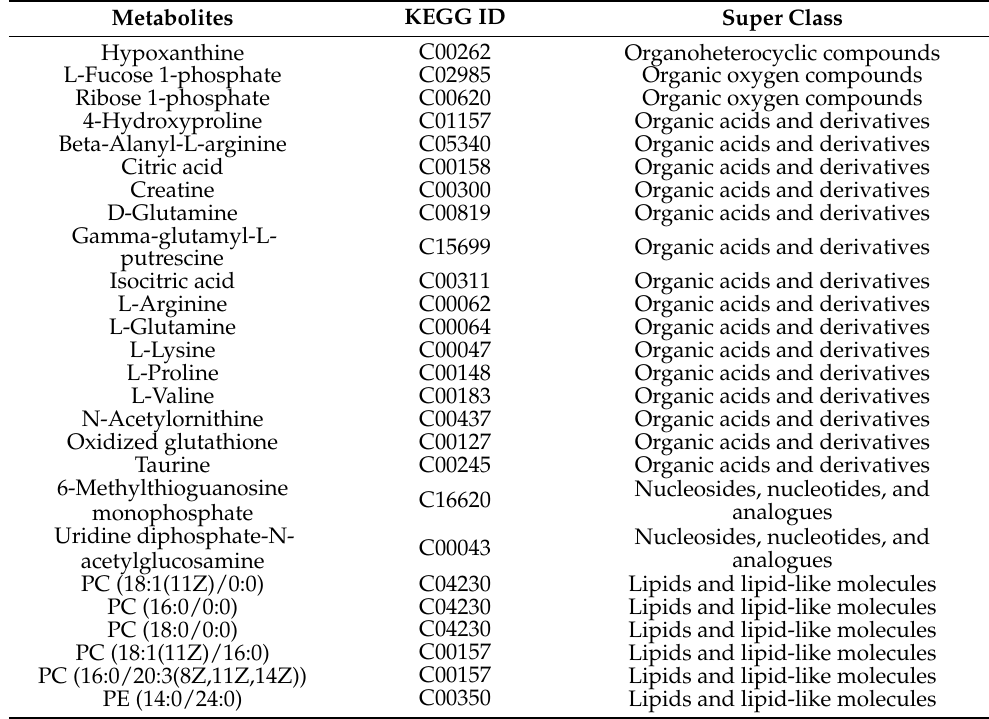
Figure 6. Metabolic pathway enrichment map (Top 20). The columns higher than the blue line mean p < 0.05, and the columns higher than the red line mean p < 0.01.